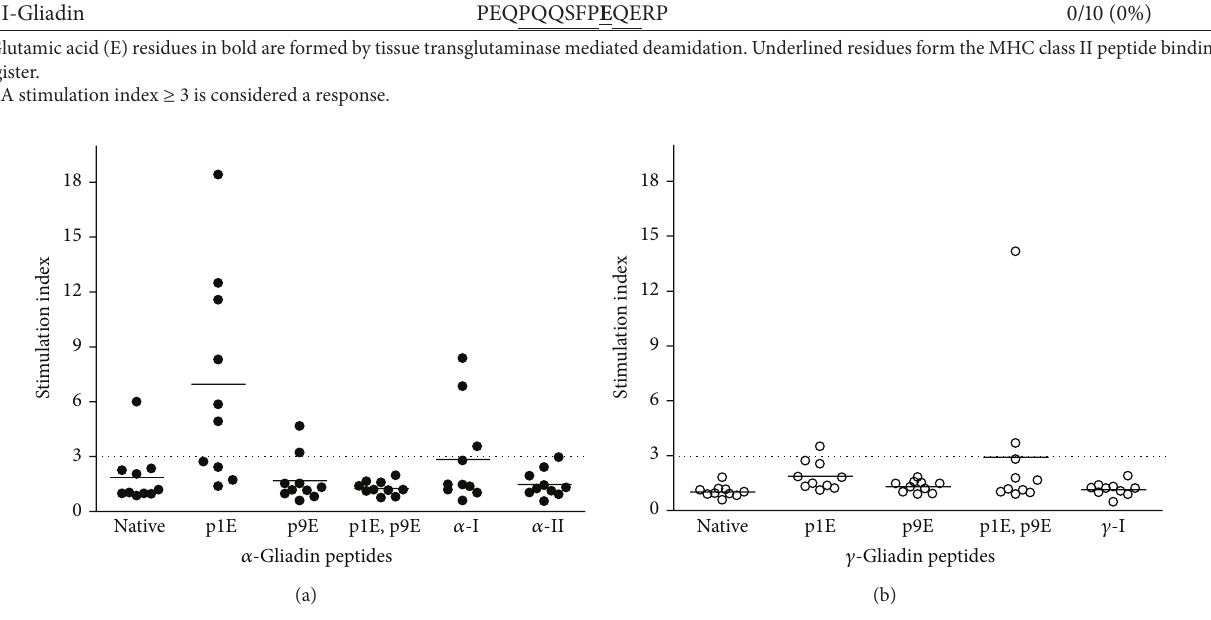
Figure 4: Proliferation of PBMCs from newly diagnosed Celiac patients to 𝛼 - and 𝛾 -gliadin peptides.(a) Proliferative responses to 𝛼 -gliadin and (b) 𝛾 -gliadin epitopes. Celiac subjects proliferate more in response to 𝛼 -gliadin peptides compared to 𝛾 -gliadin, especially the peptide deamidated at pocket 1 in which 6/10 subjects responded. Overall, there are 12/60 responses to 𝛼 -gliadin peptides compared to 3/50 for 𝛾 - gliadin ( 𝑃 = 0.049 with a Fisher’s exact test). Dotted line is at a stimulation index (CD4 + CFSE lo cells at background/peptide condition) of 3, above which a responder is